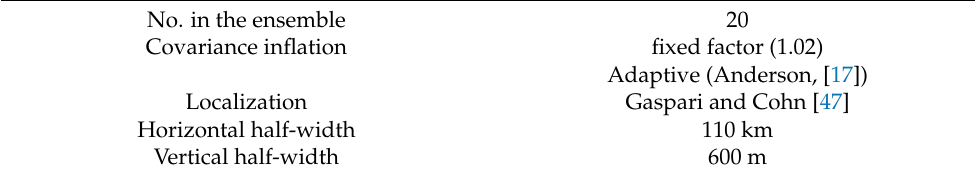
Table 1. Details of the CESM/DART EAKF for the ocean component. No. in the